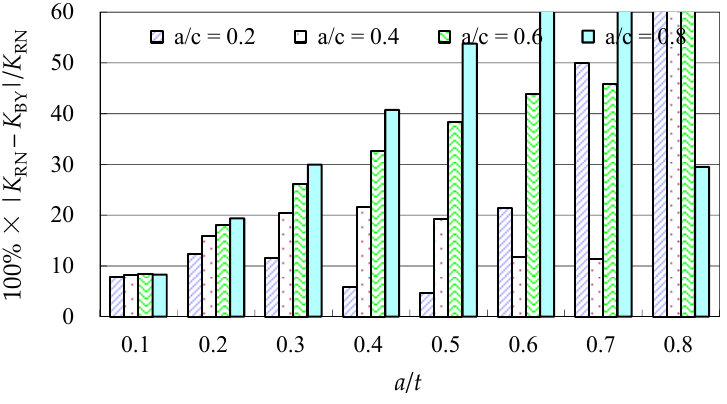
Figure 4. The Baik-Yamada formula vs. the Raju-Newman solution at point B ( c / W = 0.1).